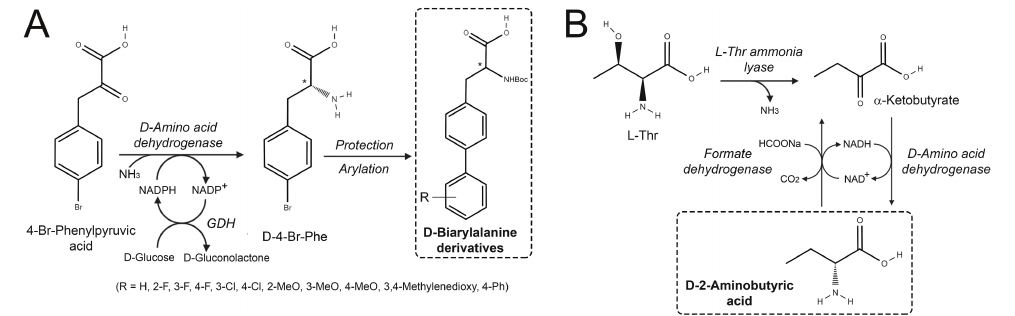
Figure 3. Use of engineered D-amino acid dehydrogenases in production of D-AAs. Synthesis of D-AAs by: ( A ) direct conversion by engineered D-amino acid dehydrogenase of 4-Br-phenylpyruvic acid into